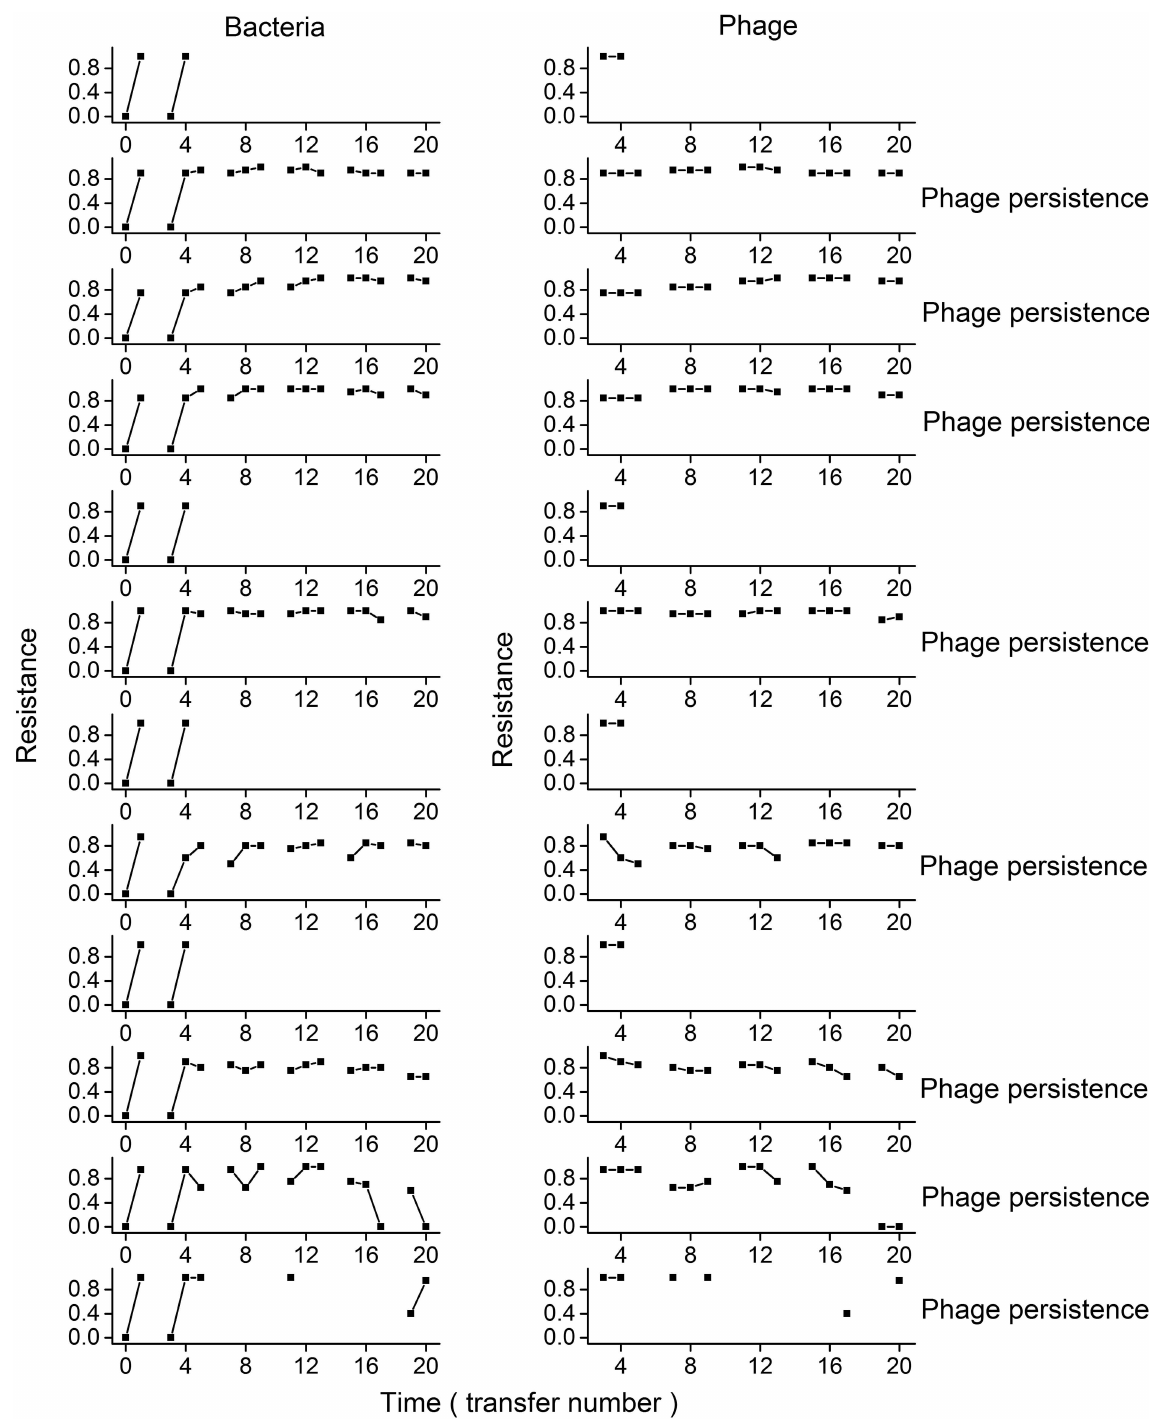
Fig 4. Change in bacterial resistance and phage infection in intermediate-resource microcosms. Symbols are as in Fig 3.